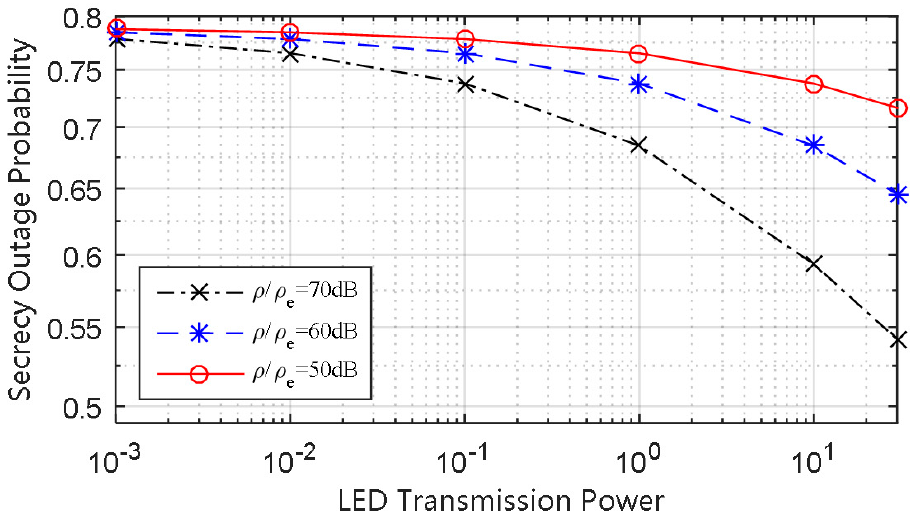
Figure 6. SOP of the strong user versus the ratio of ρ / ρ e